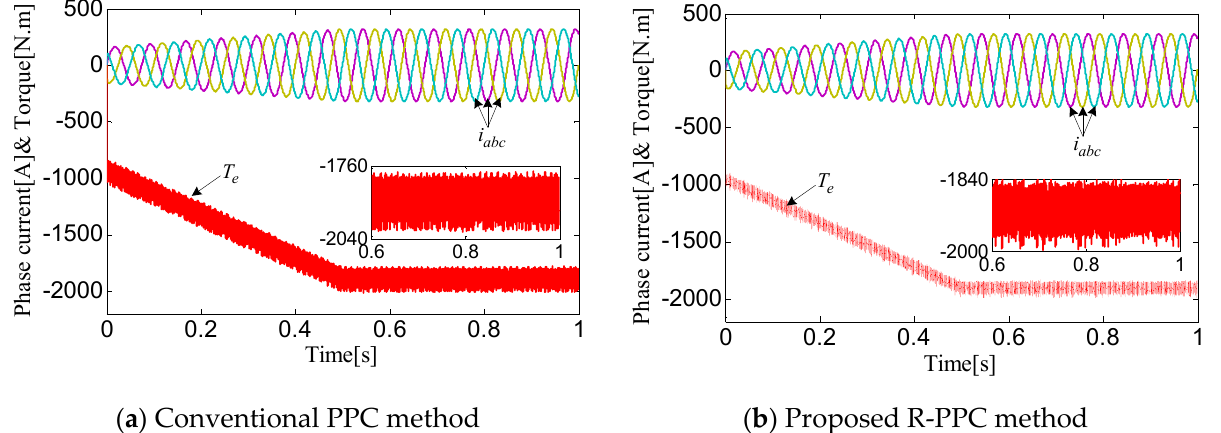
Figure 11. Simulation results of the phase current and torque under the discharge state. ( a ) Conventional PPC method; ( b ) Proposed R-PPC method.